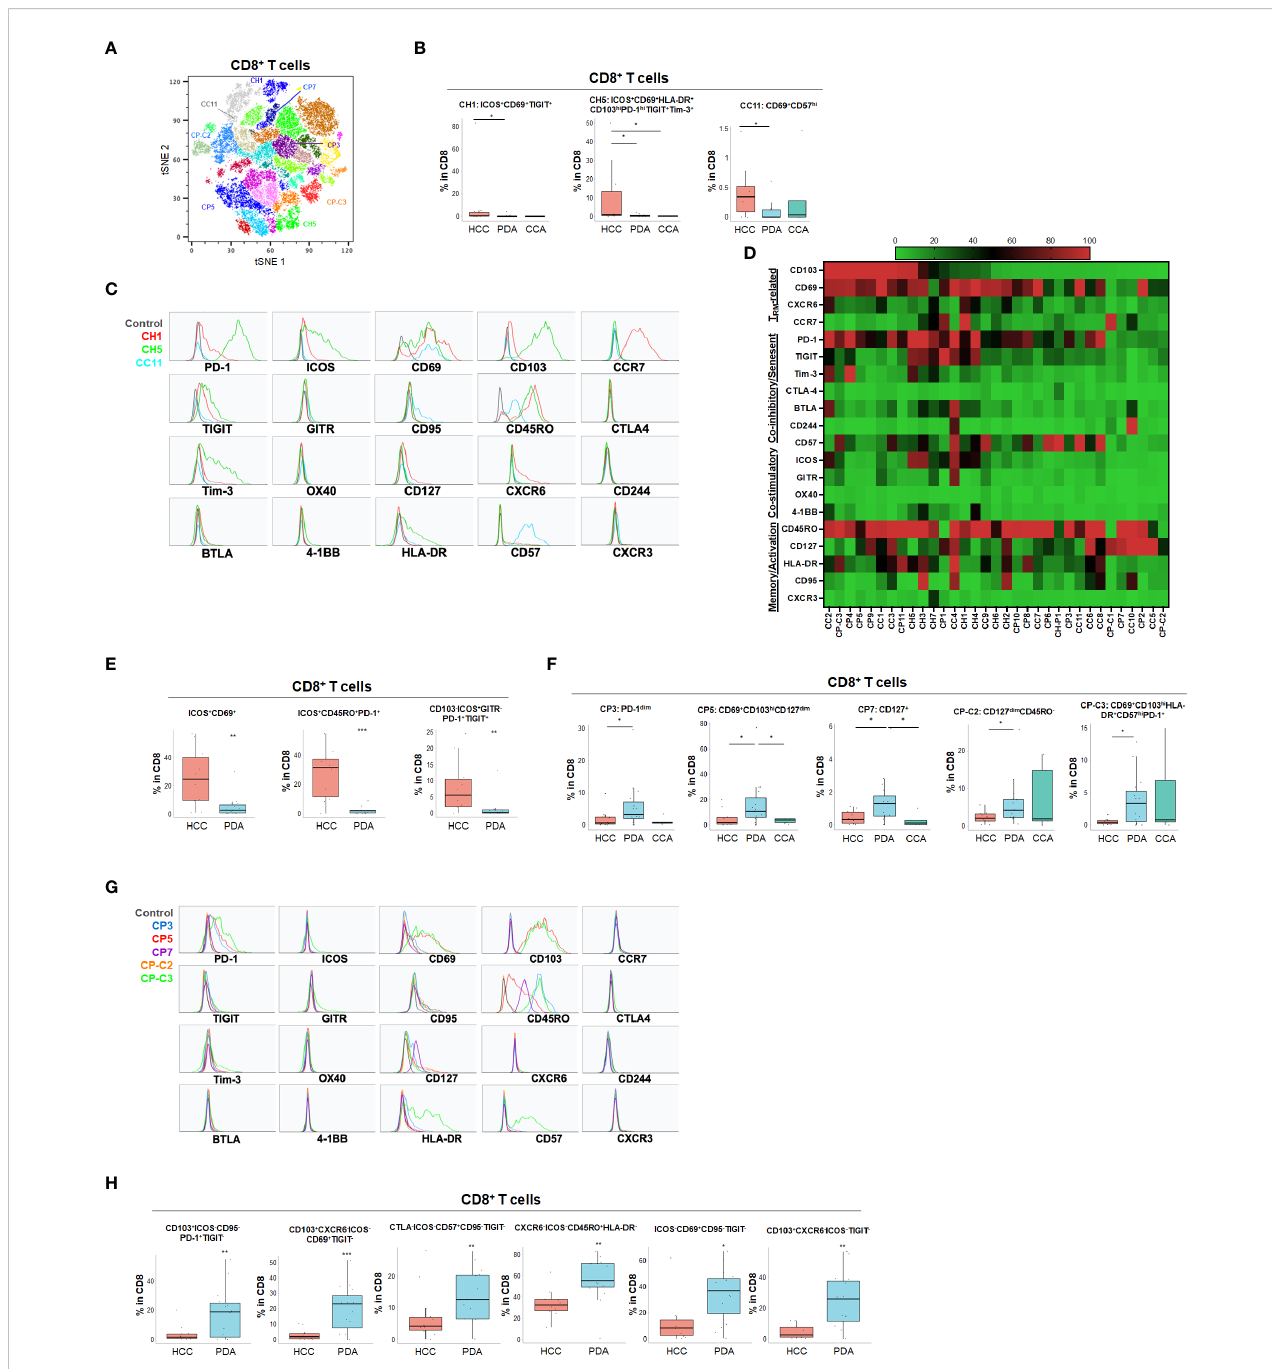
FIGURE 2 Distinct CD8+ T cell phenotypes in liver and pancreatic cancer. (A) t-distributed stochastic neighbor embedding (tSNE) projection of CD8+ T cells showing manual-gated clusters identi fi ed from HCC (n=11), PDA (n=20) and CCA (n=5) patients. Signi fi cantly enriched clusters in HCC (CH1, CH5, CC11) and PDA (CP3, CP5, CP7, CP-C2, CP-C3) are labeled. (B) Boxplots showing percentage of indicated HCC-enriched clusters and phenotype for CH1, CH5 and CC11 in CD8+ T cells from tSNE (A) comparing HCC, PDA and CCA. Box middle lines, median; box limits upper and lower quartiles; box whiskers, 1.5x the interquartile range. *p < 0.05; Kruskal-Wallis test. (C) Histograms showing individual marker expression of the HCC-enriched clusters CH1 (red), CH5 (green) and CC11 (blue) in CD8+ T cells. (D) Expression of TRM-related markers, co-inhibitory/senescent markers, co-stimulatory markers